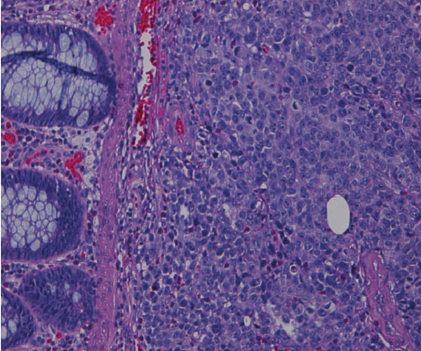
Figure 2: Sigmoid colon mass biopsy showing neoplastic prolifera- tion of cells within the mucosal layer.